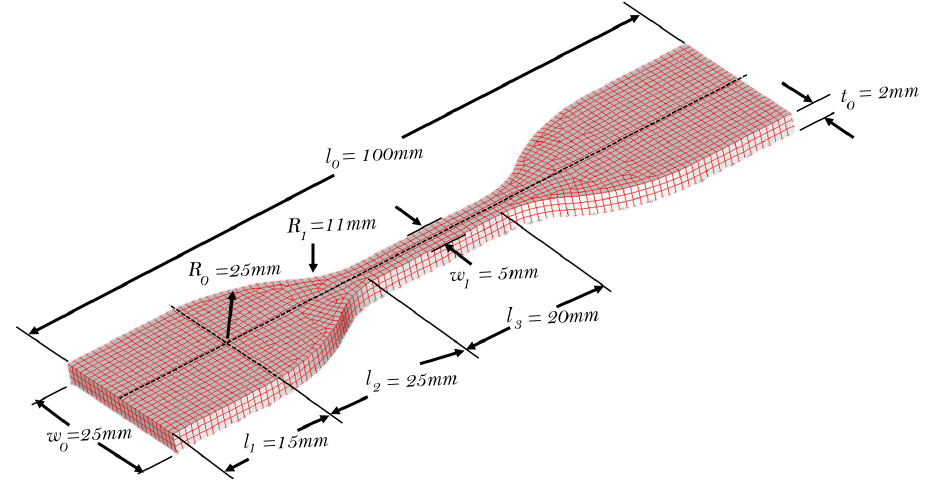
Figure 3. KS M 6518 specimen and